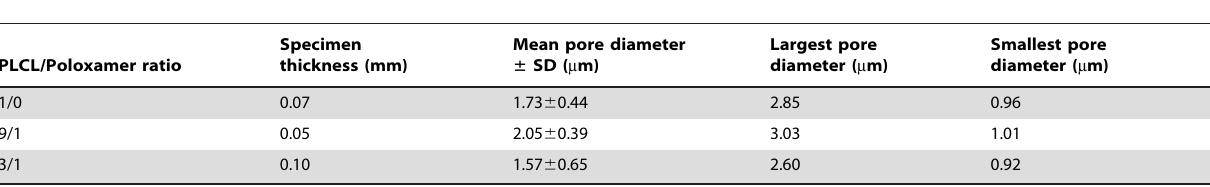
Table 1. Pore diameter of PLCL and PLCL/Poloxamer nanofibers with various blend ratios.